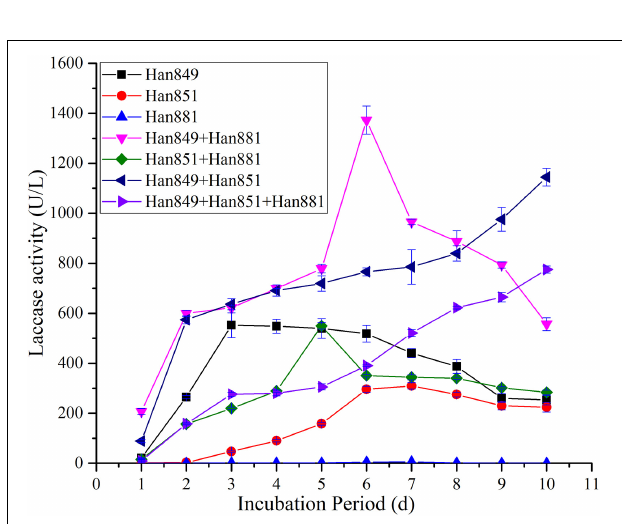
FIGURE 3 | Laccase activity from single or mixed fungal species on Firmiana platanifolia in submerged fermentation.